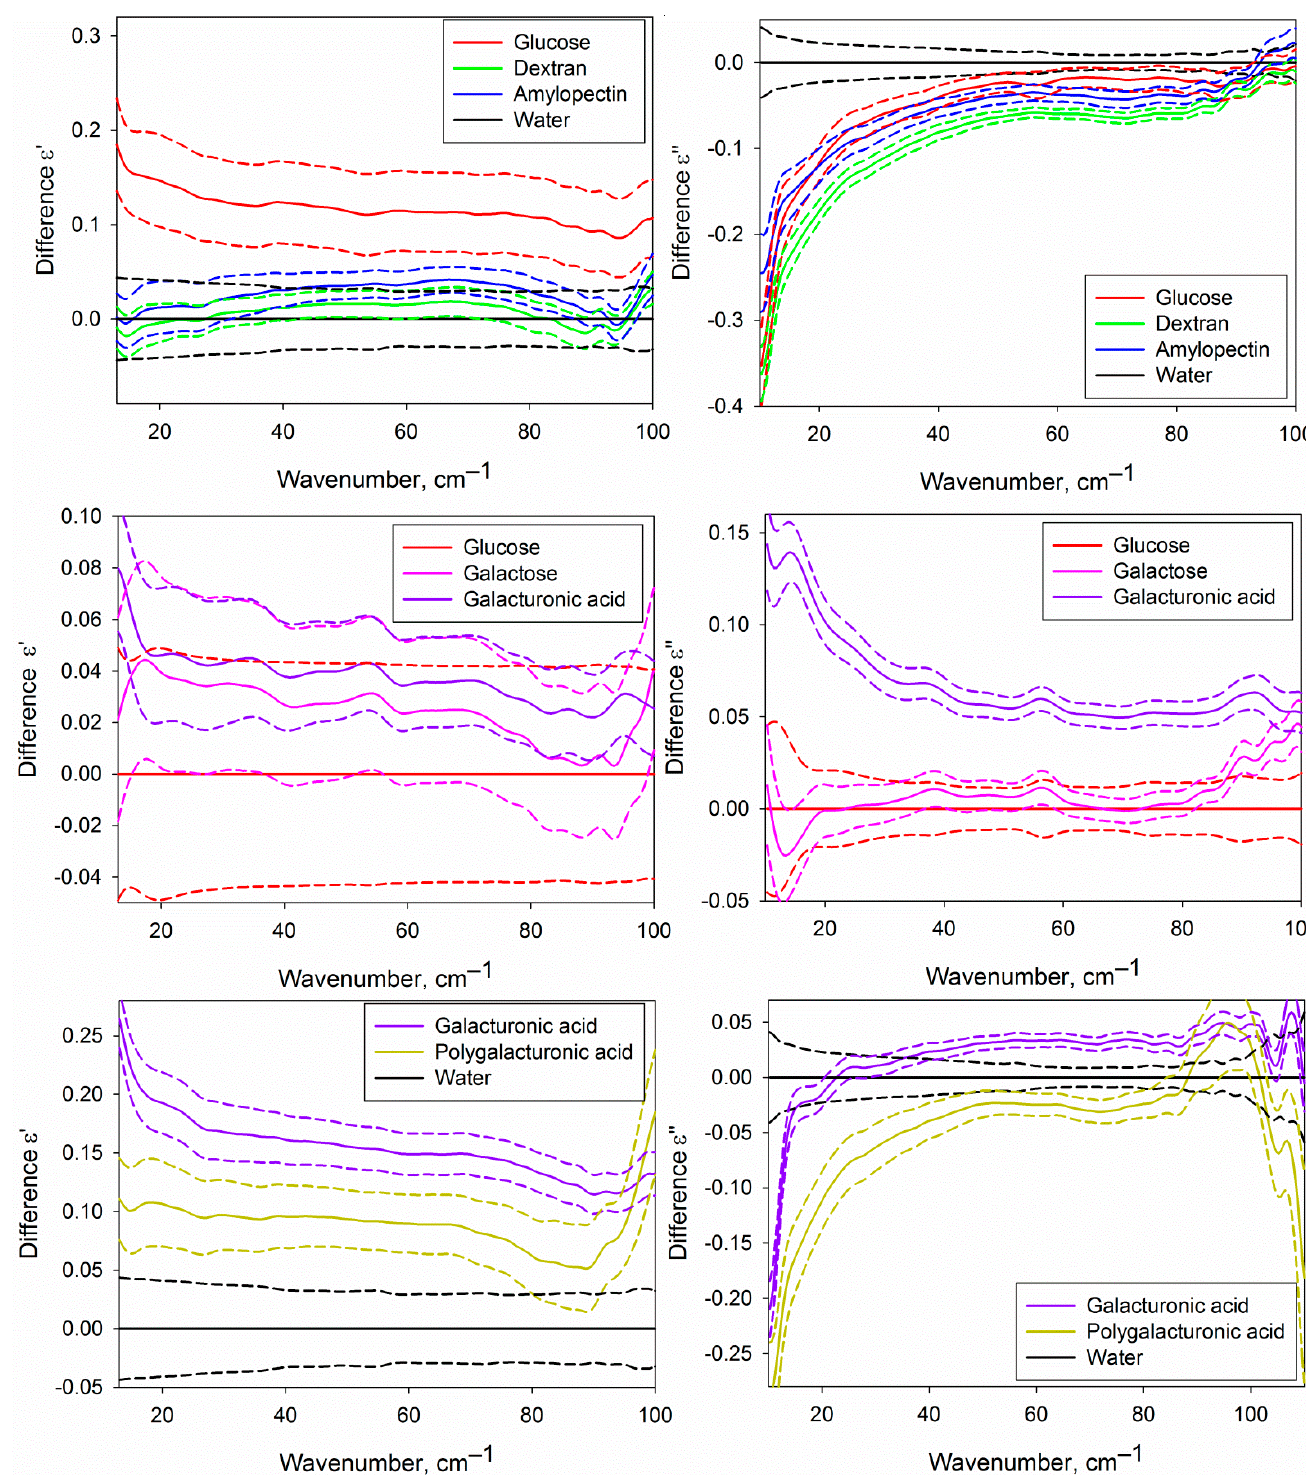
Figure 5. Differential dielectric permittivities (real 𝜀′ and imaginary 𝜀′′ parts) of the water phase of the studied aqueous carbohydrate solutions. The upper part corresponds to the solutions of glucose, dextran and amylopectin compared with water; the central part, to the solutions of galactose and galacturonic acid compared to glucose solution; lower part, to the solutions of galacturonic and polygalacturonic acid compared to water. Solid lines represent averaged DPs, and dashed lines of the same colour show the dispersion as a 95% mean confidence interval.